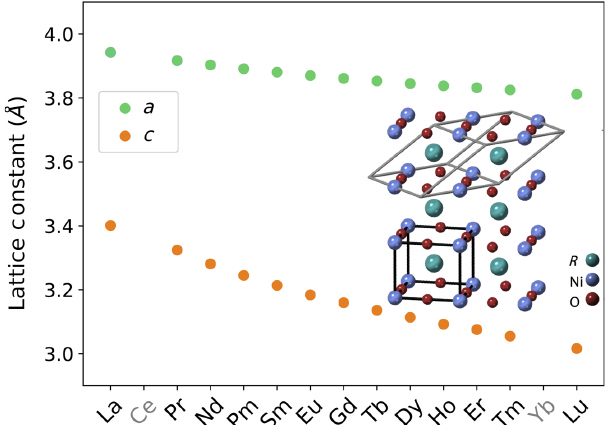
FIG. 1. Lattice constant and crystal structure of R NiO 2 . The figure shows the DFT(GGA) relaxed R NiO 2 lattice constants. Inset: crystal structure for infinite-layer nickelate R NiO 2 . One-Ni unit cell (black) for the paramagnetic calculation and two-Ni unit cells (gray) for ( π , π , π ) the antiferromagnetic calculation are shown,